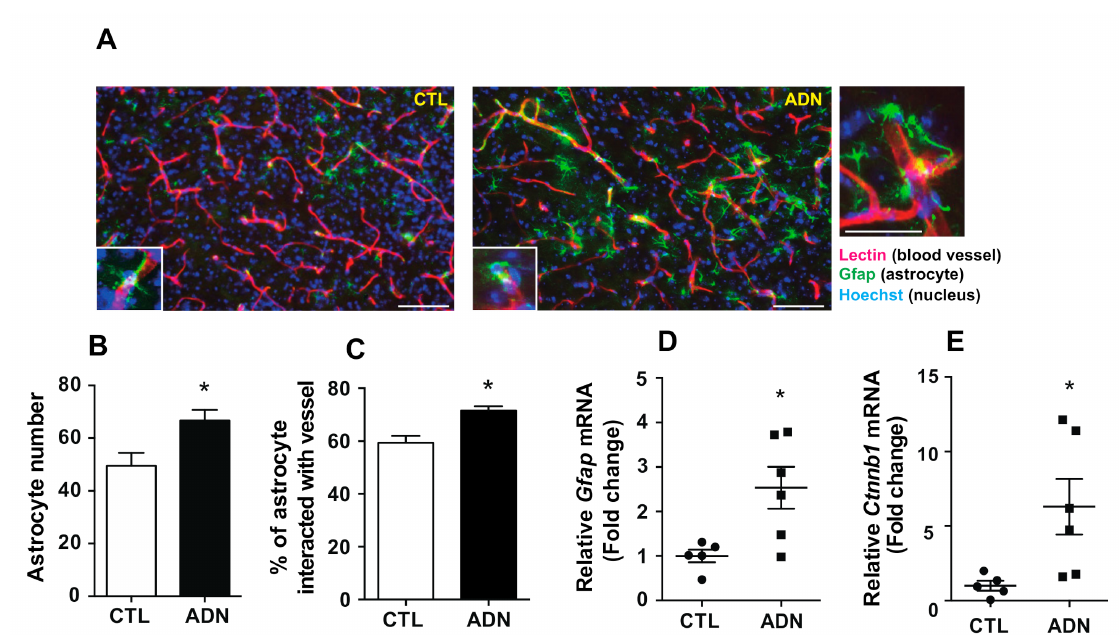
Figure 1. Central administration of adiponectin leads to activation of hypothalamic astrocytes. The whole brain was collected from mice that received an intracerebroventricular (icv) injection of adiponectin (ADN, 3 µ g/2 µ L) and intracardiac injection of lectin. The distribution of astrocytes was examined by immunohistochemistry using an antibody against glial fibrillary acidic protein (Gfap), a molecular marker for astrocytes. ( A ) Representative images of Gfap immunolabeling in the hypothalamus. Icv administration of adiponectin led to increased ( B ) number of astrocytes and ( C ) contact ratio between astrocytes and blood vessels in the hypothalamus of the mouse brain ( n = 5 for each group). Icv administration of adiponectin elevated mRNA levels of ( D ) Gfap and ( E ) Ctnnb1 as determined by qRT-PCR ( n = 5 for CTL; n = 6 for ADN). Results are presented as mean ± SEM. * p < 0.05. Scale bar = 50 µ